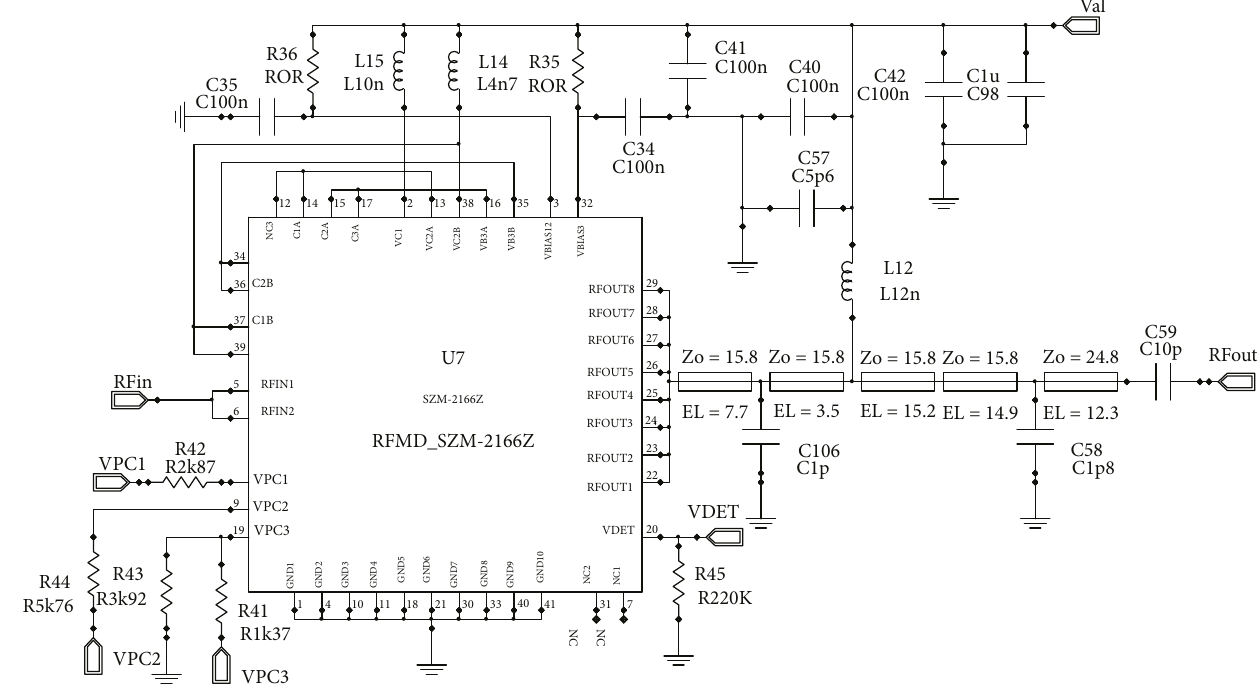
Figure 6: Schematic of power ampli fi er (SZM-2166Z).